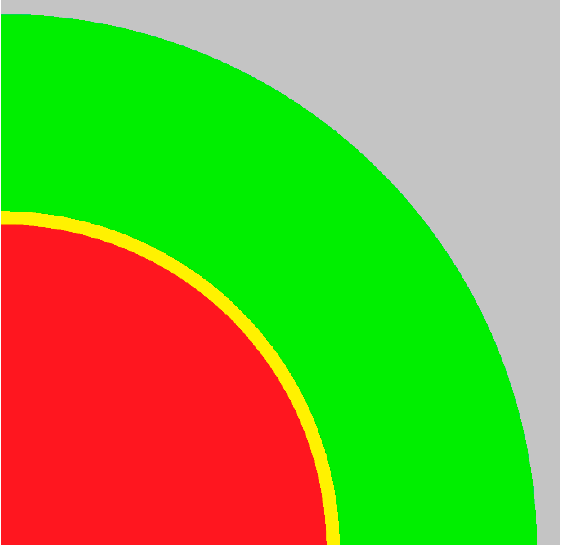
Figure 4. The 2 ‐ D SCALE/TRITON ‐ NEWT model (molten salt fuel core—red, stainless steel—yellow, NaCl reflector—light green, vacuum—grey) used for the analysis of the neutron flux distribution.